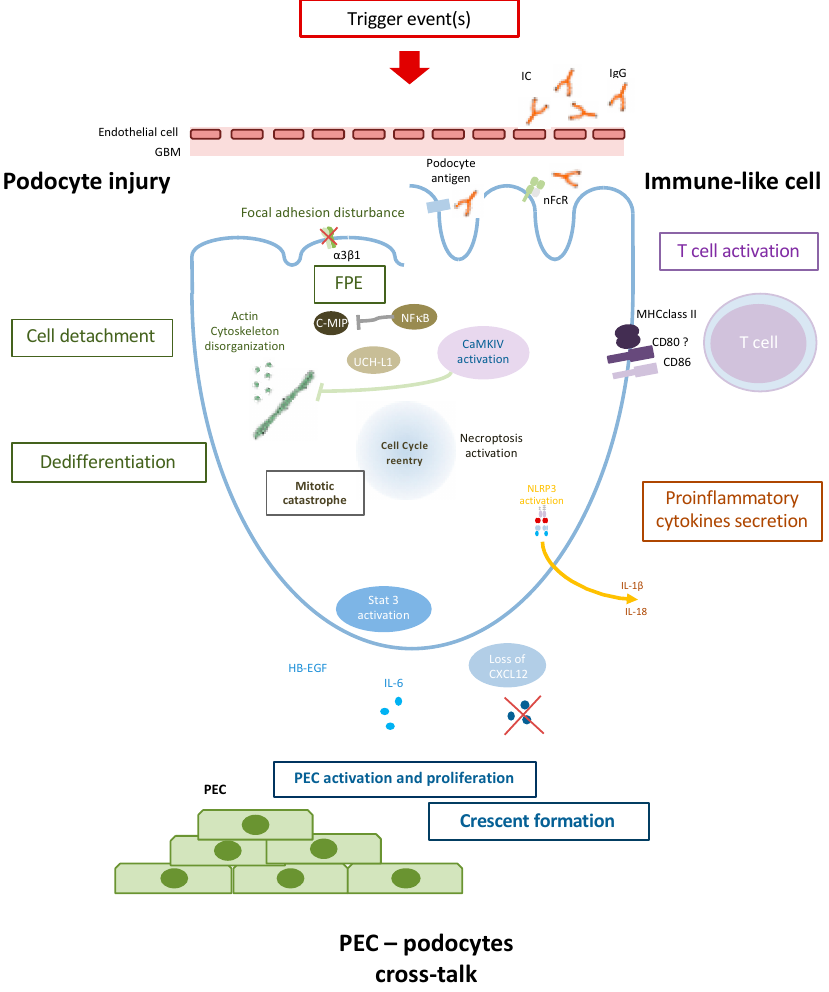
Figure 1. Podocyte contribution to glomerular lesion in proliferative Lupus nephritis.